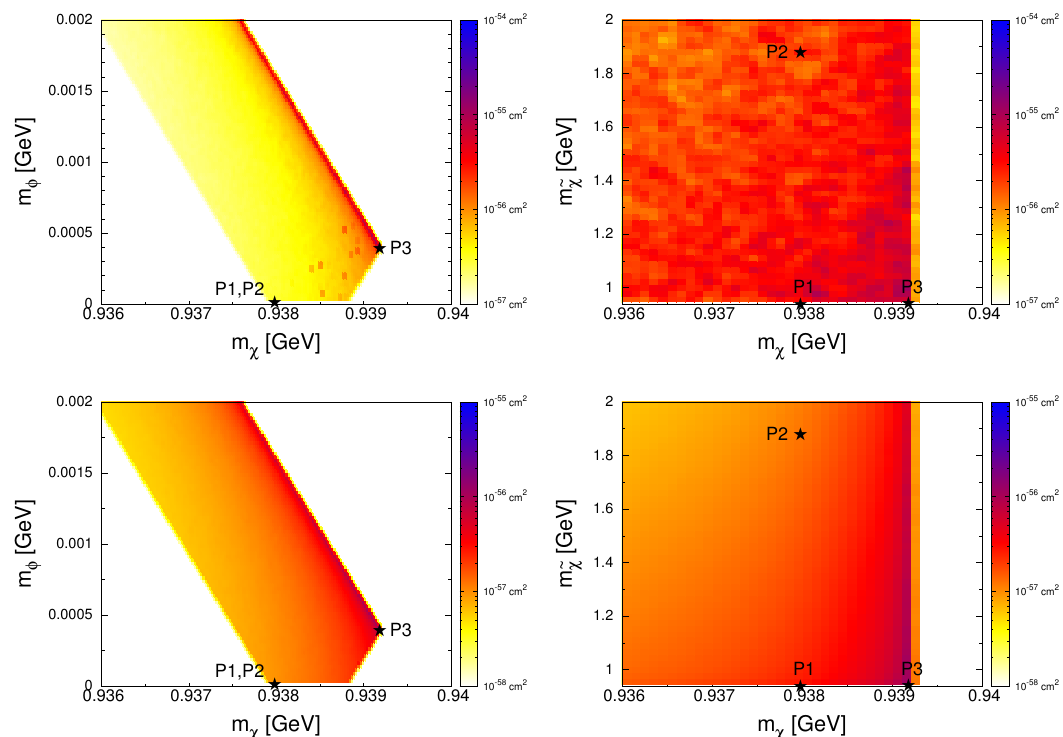
Figure 3 . The maximum (upper panels), and minimum (lower panels) values of v projected on the ( m (cid:31) , m (cid:30) ) plane (left panels), and the ( m (cid:31) ; m mark the three benchmark points P1 , P2 , and P3 . We set y =